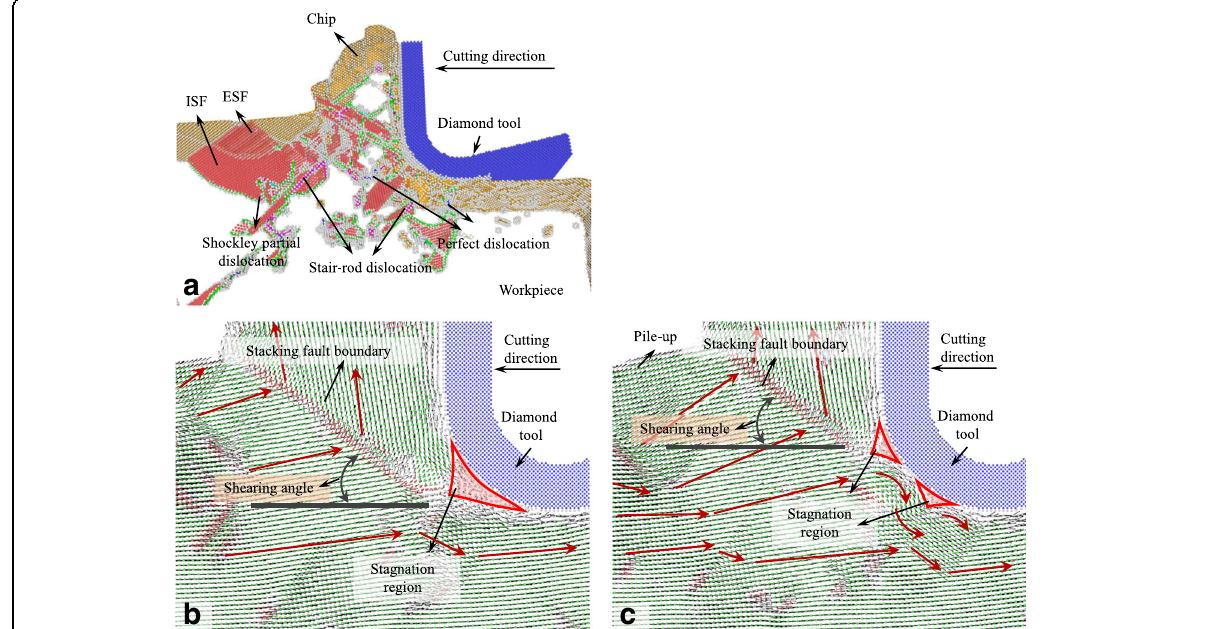
Fig. 2 a Snapshots of the microstructure evolution at cutting direction of {100}<001>, displacement vector sliced at b 4 and c 6 nm in z